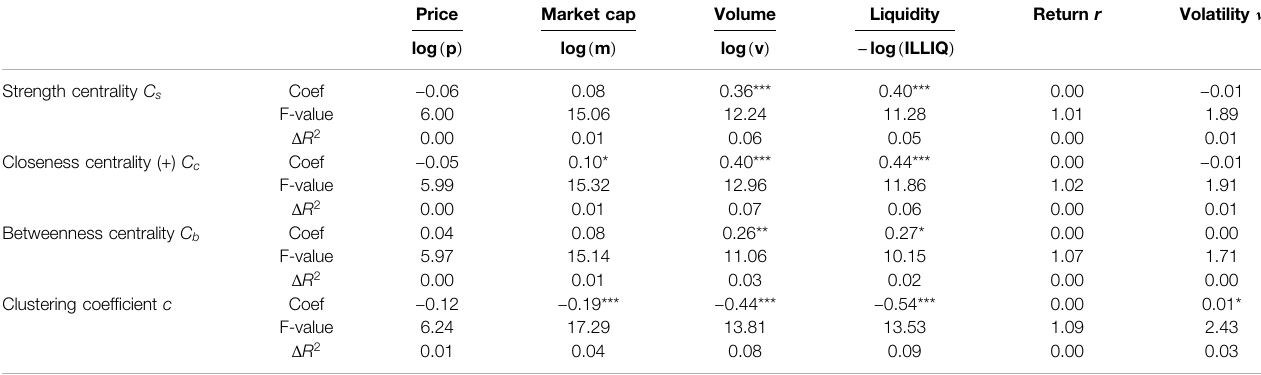
TABLE 4 | Regressions between the market indicators and the tokens ’ market embeddedness (model